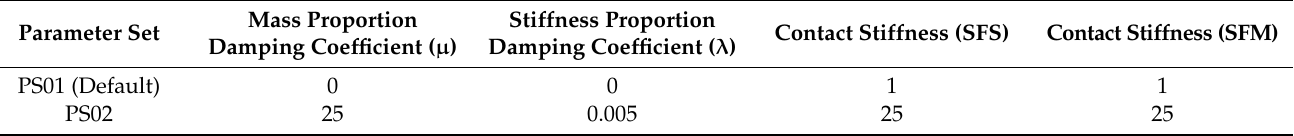
Table 3. Simulation parameter